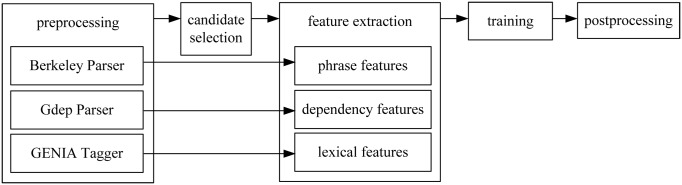
System architecture.